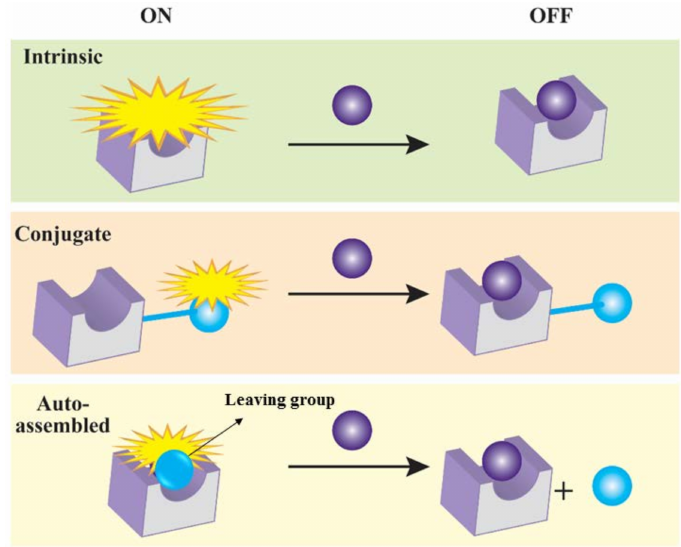
Figure 2. Types of fluorescent chemosensors based on functionality. Top panel: intrinsic; mid- dle panel: conjugate; bottom panel: auto-assembled chemosensors. On arrow: sphere represents an “analyte”.